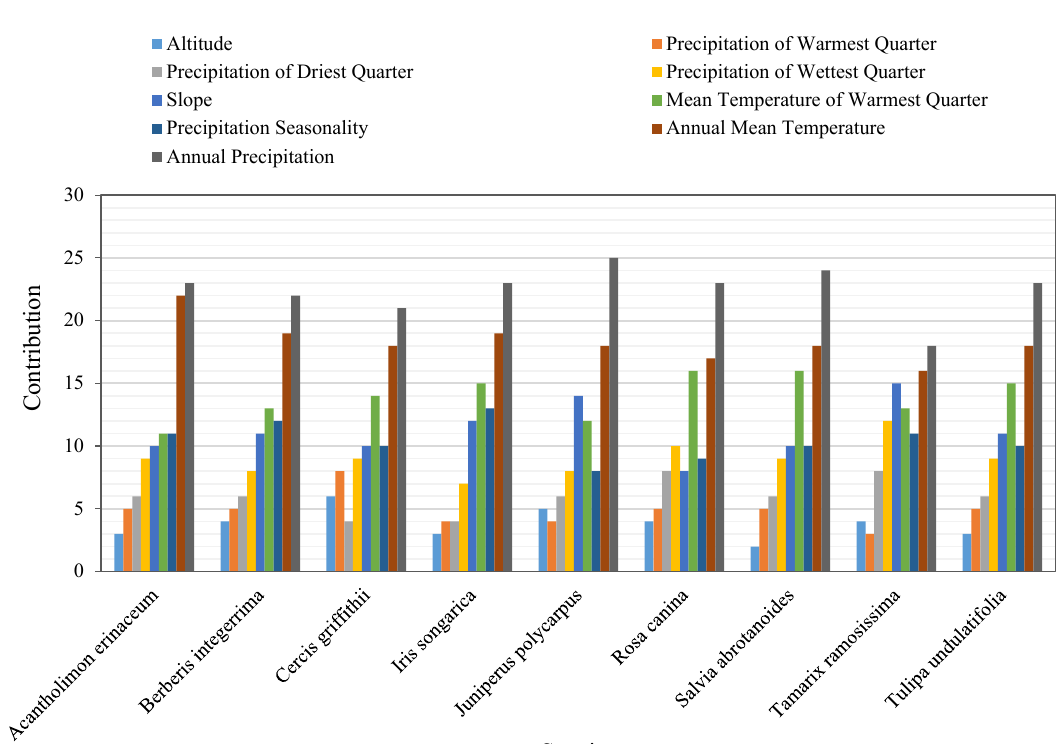
Fig. 10: Importance of environmental variables for all species.